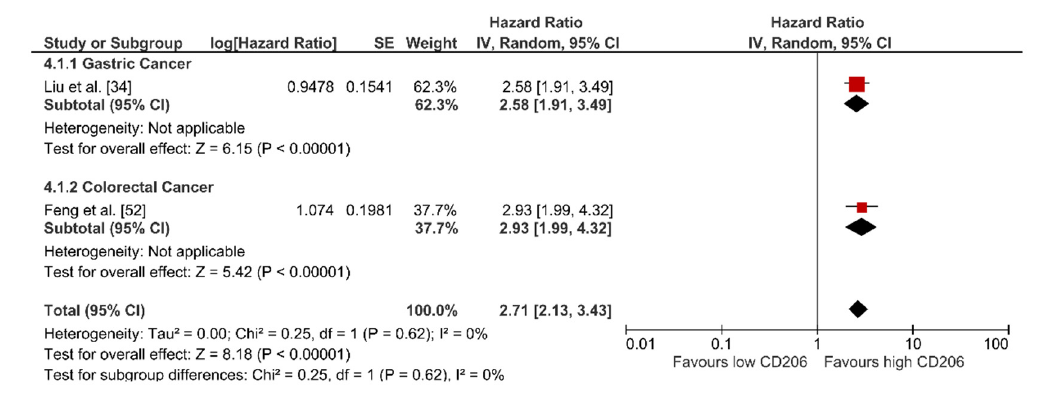
Figure A4. Forrest plot of impact of CD206-expression on disease specific survival of patients diagnosed with solid cancers. SE: standard error; IV: Interval variable; CI: confidence interval; df: degrees of freedom.